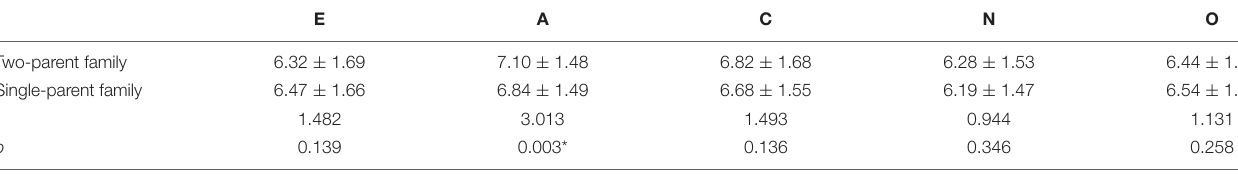
TABLE 3 | Comparison of personality traits between two-parent family and single-parent family.